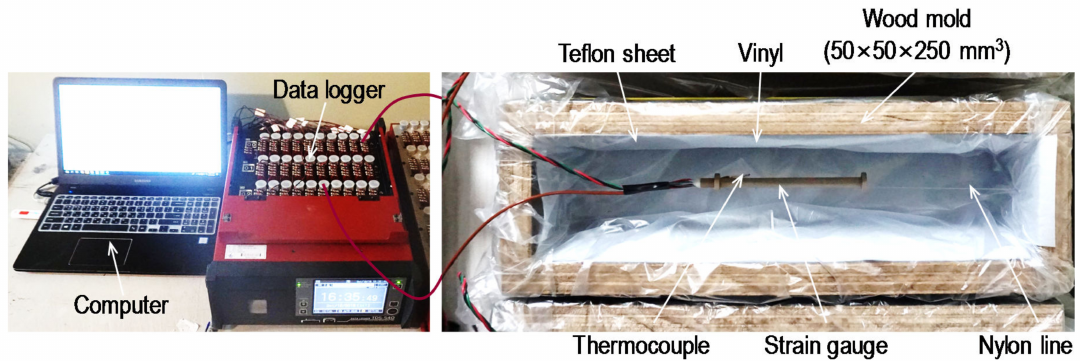
Figure 4. Test setup for the free shrinkage